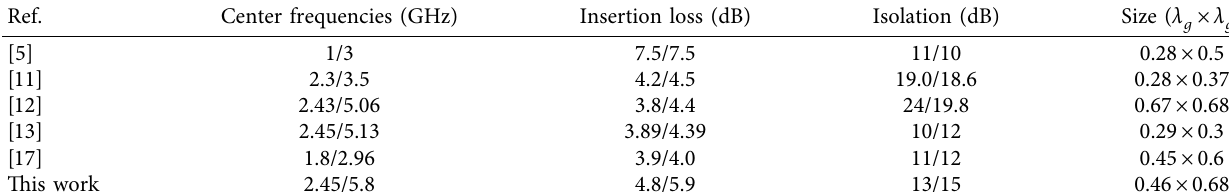
Table 1: Comparisons with previous works.